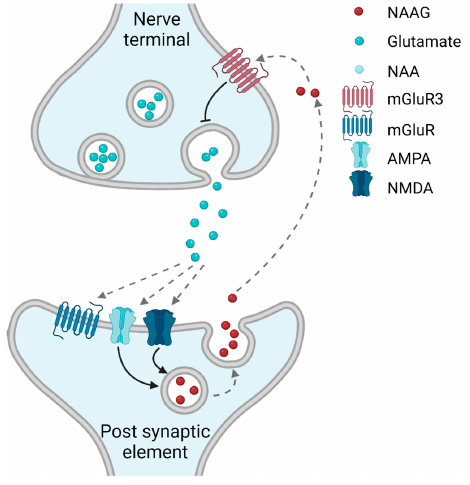
Figure 1. Retrograde exocytosis of N-acetyl-aspartyl-glutamate (NAAG) modulates glutamatergic neurotransmission. The postsynaptic release of NAAG is induced by the activation of postsynaptic ionotropic glutamate receptors. When released into the synaptic cleft, NAAG activates presynaptic metabotropic glutamate receptor 3 (mGluR3), reducing further glutamate release. Figure created with BioRender.